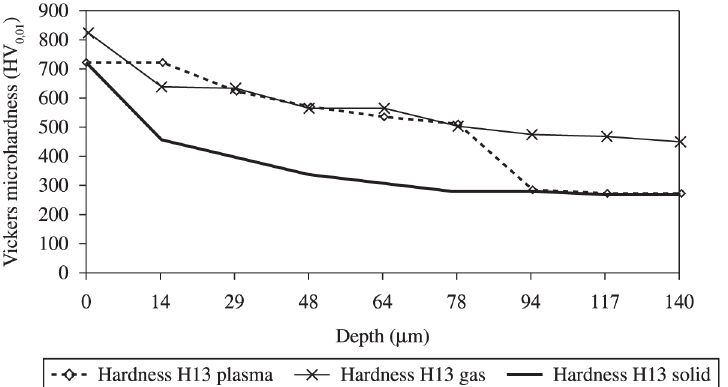
Figure 3. Microhardness profile for samples of AISI H13, nitrided by three different processes (plasma, gas, and solid